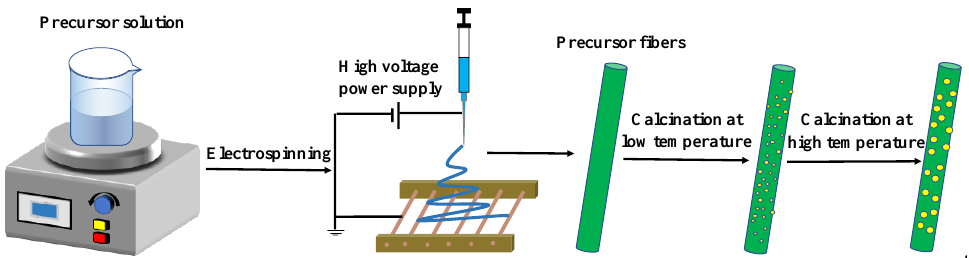
Figure 1. The scheme diagram of electrospinning process of S/CdO@In 2 O 3 hybrid nanofibers during the calcinations process.